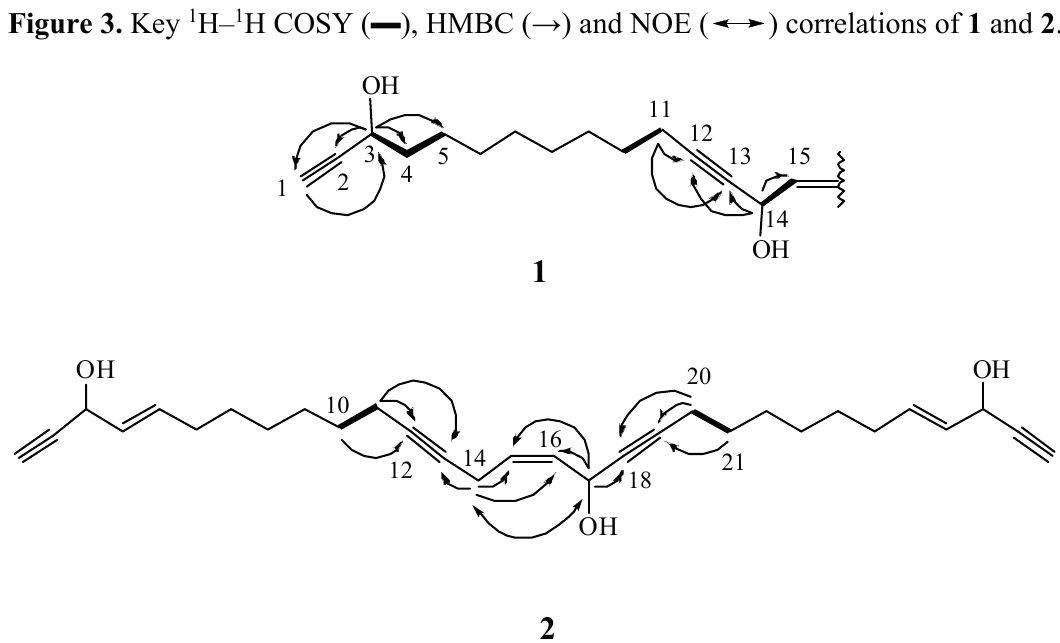
Figure 3. Key 1 H– 1 H COSY ( ▬ ), HMBC ( → ) and NOE ( ) correlations of 1 and 2